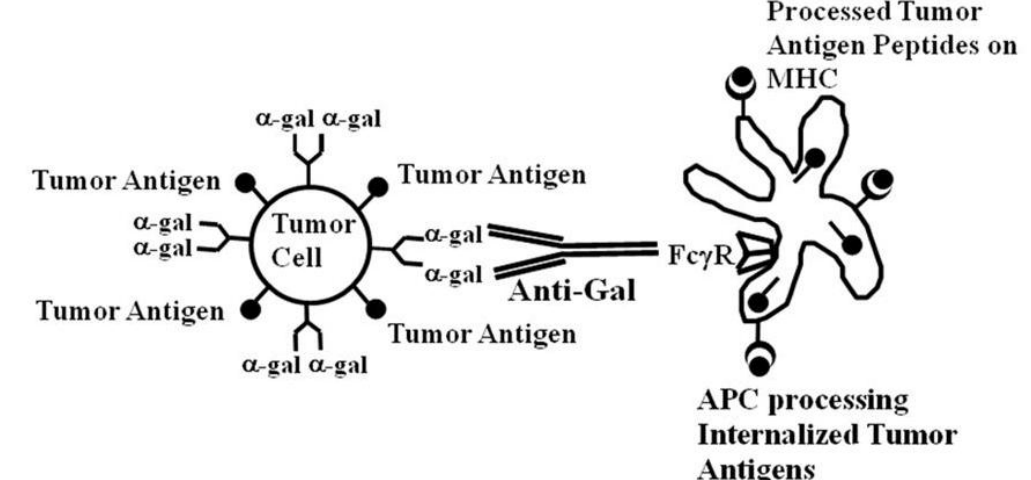
Figure 5. Anti-Gal mediated targeting of tumor cells to APC in lesions injected with  -gal glycolipids. Anti-Gal IgG binds in situ to  -gal epitopes on  -gal glycolipids inserted into tumor cell membranes. Subsequent interaction between the Fc portion of the bound anti-Gal and Fc  R on the APC (schematic illustration of a dendritic cell) induces uptake of intact or lysed tumor cells by APC and thus, effective internalization of the tumor antigens (MAA in melanoma lesions). Internalized tumor antigens are processed and various immunogenic tumor antigen peptides (  ) are presented by the APC in association with class I and class II MHC molecules. These immunogenic peptides can activate tumor specific T cells and elicit a protective anti-tumor immune